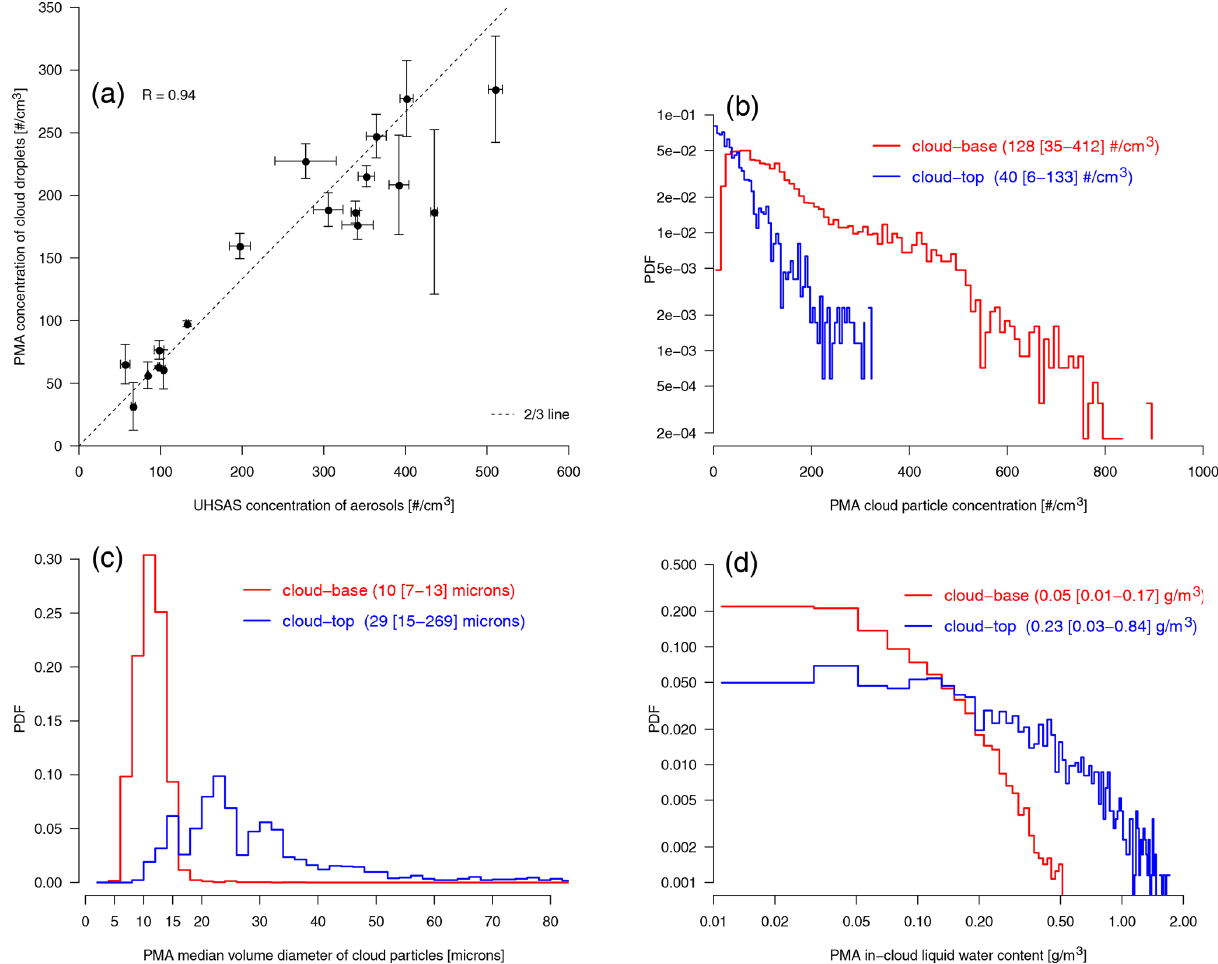
Figure 10. (a) Relationship between the concentration of aerosols (from the UHSAS dataset) and the concentration of cloud droplets (from the PMA dataset, excluding drizzle and rain particles) calculated for the R patterns flown at cloud base during the whole EUREC 4 A campaign. The mean of each ATR flight is reported together with the standard deviation among the different R patterns of the flight. Other panels (b, c, d) show the probability distribution function (calculated over all the R patterns flown at cloud base or at cloud top) of (b) the total concentration of cloud particles, (c) the median volume diameter (MVD) of cloud particles and (d) the in-cloud liquid water content (LWC) derived from the composite PMA dataset. The median of each quantity is reported, together with the 10th and 90th percentiles of each distribution (in brackets). (b–d) Histograms are calculated for in-cloud conditions (where cloud particles can coexist with drizzle or rain